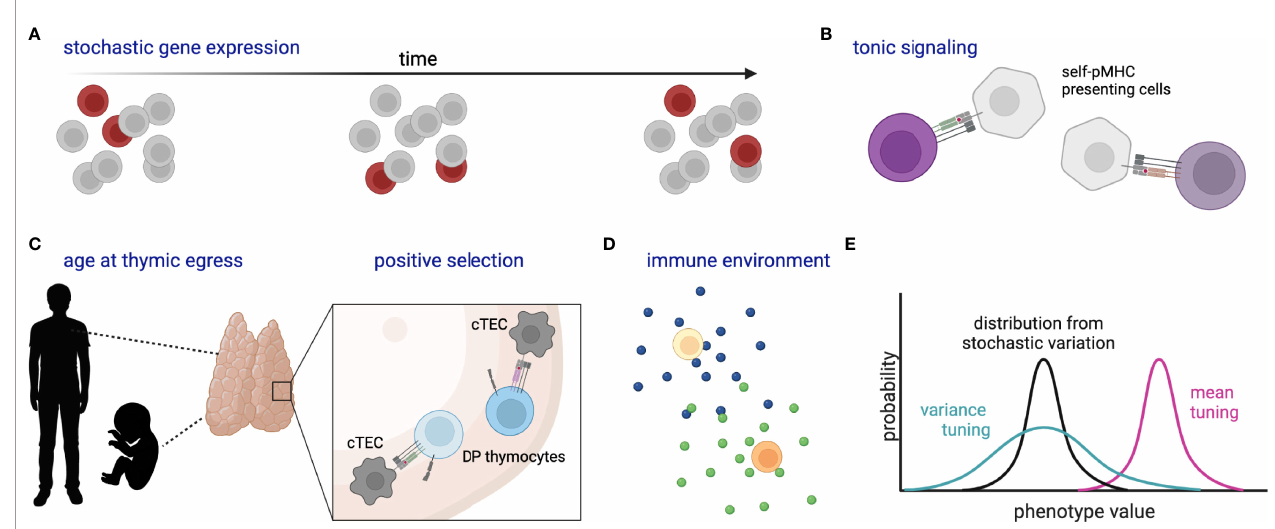
FIGURE 3 | Schematic of stochastic and deterministic sources of naïve T cell heterogeneity. (A) Stochastic gene expression bursting within a population over time, where dark red cells indicate those cells randomly expressing the gene of interest at each time point. (B) Varied self-pMHC binding of naïve T cells affects gene expression and response characteristics. (C) Likewise, organism age at thymic egress (particularly adult versus fetus) and the strength of self-pMHC interaction during positive selection affect gene expression and response characteristics of peripheral naïve T cells; cTEC, cortical thymic epithelial cell; DP, double-positive. (D) Cytokines and other environmental components tune naïve cell reactivity. (E) Cartoon histograms depict the probability of a cell exhibiting a certain phenotype (e.g. expression of CD8 or a particular metabolic state). Stochastic variation as in (A) creates a distribution (black) which might then be tuned in variance (green) and/or mean (magenta) by additional factors such as (B – D) . All cells represent naïve T cells unless otherwise speci fi ed. Created with